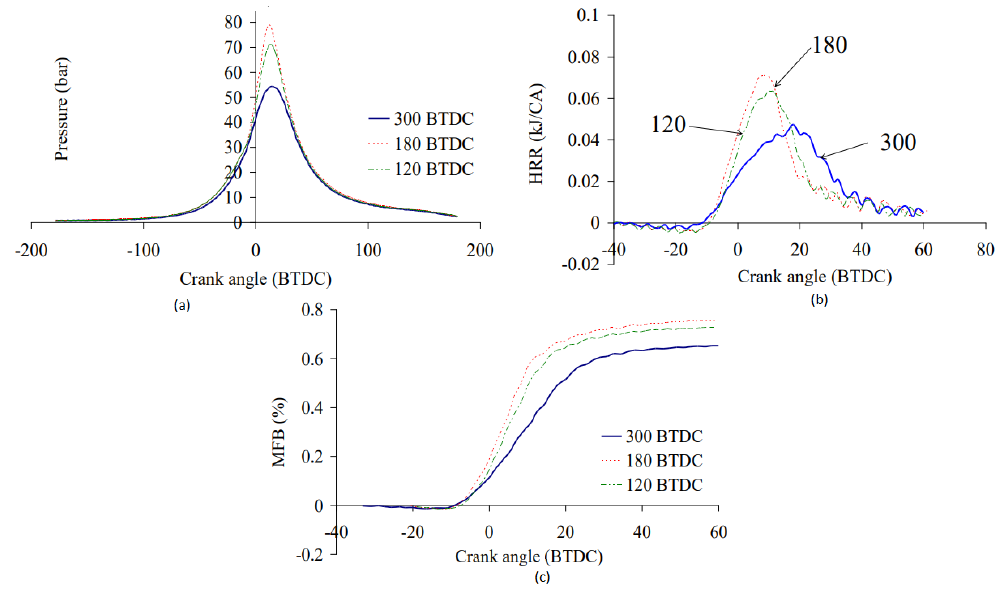
Figure 16. In-cylinder pressure ( a ), heat release rate ( b ), and mass fraction burned ( c ) for different injection timings at an engine speed of 3000 rpm [213].